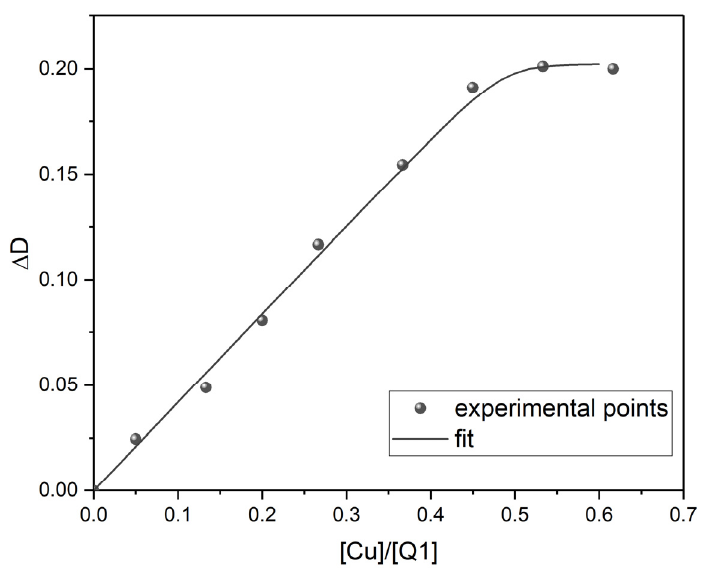
Figure 3. The dependence of the relative change of the ligand absorption ( ∆ D) at 435 nm on Cu(II)/Q1 concentration ratio in ethanol.